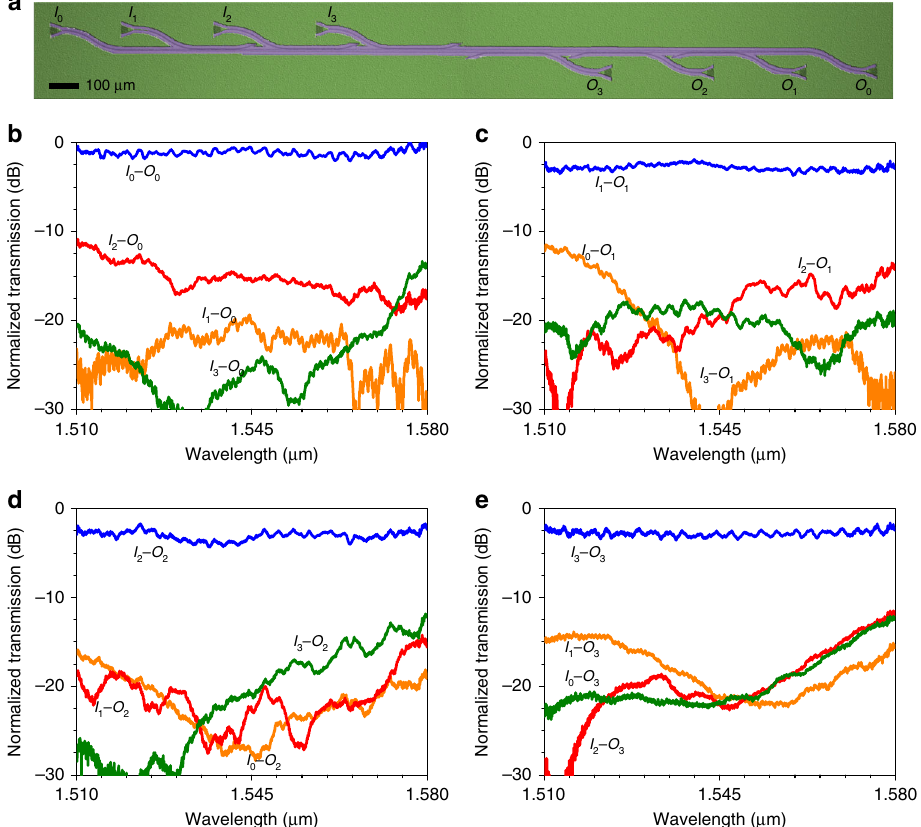
Fig. 5 Experimental demonstration of mode (de)multiplexing with BICs. a Optical microscope image of the fabricated mode (de)multiplexer. b – e Normalized spectra of light transmission from each of the four input ports I 0 ‒ I 3 to each of the four output ports O 0 ‒ O 3 .